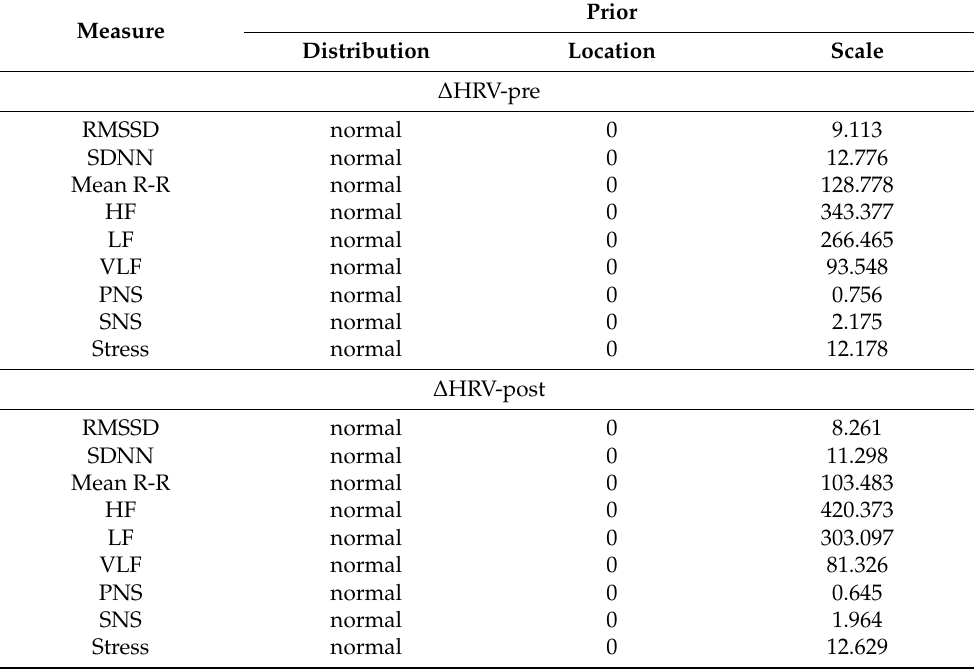
Table A1. Information of the prior used for each constant model. Weakly informative priors with large scales ( σ ) centered around zero (with µ = 0) were used, allowing some probability to extreme